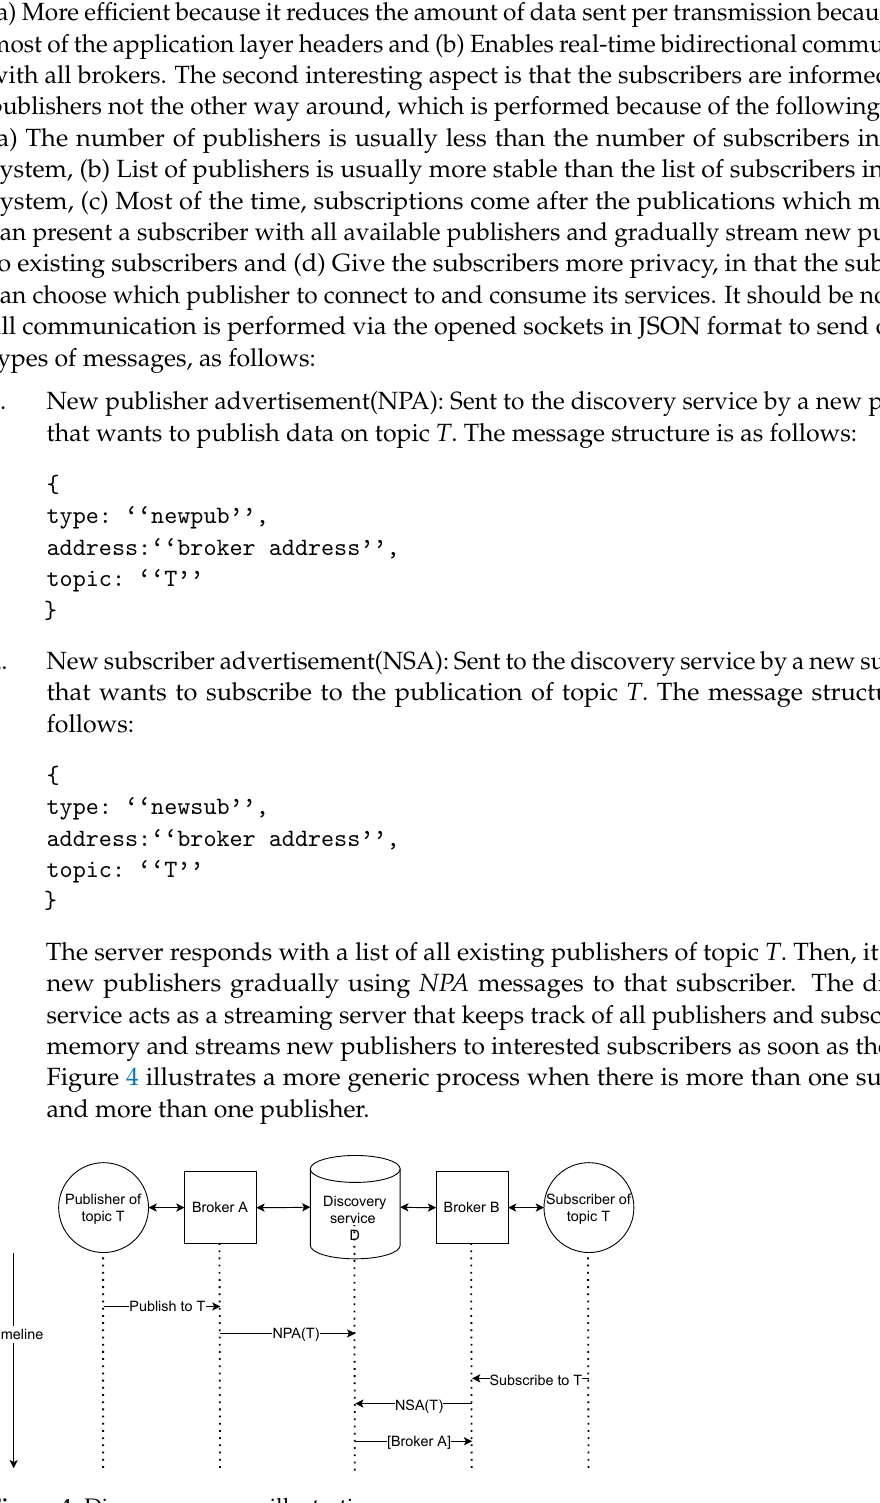
Figure 4. Discovery process